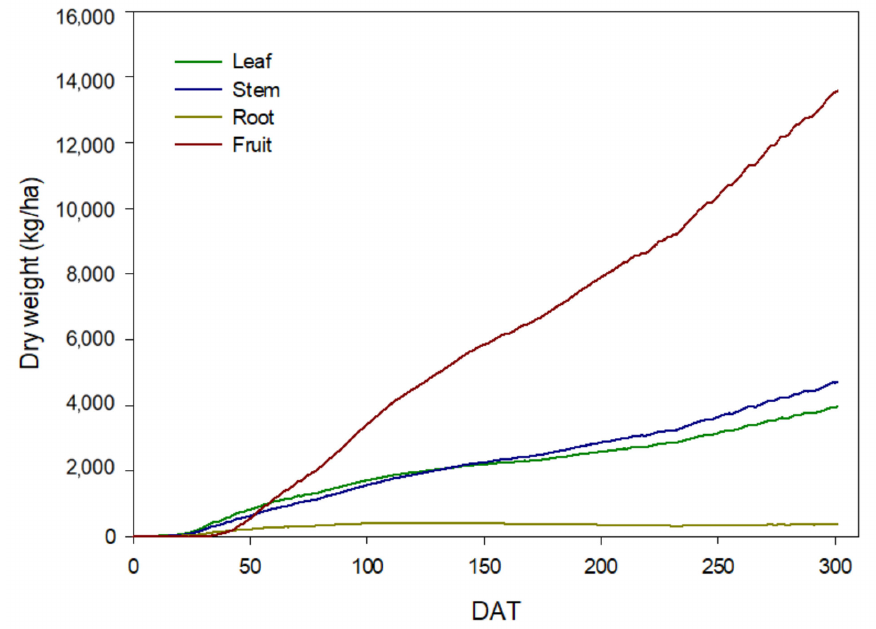
Figure 7. Dry weight of each organ estimated by the process-based model (PBM) with days after transplanting